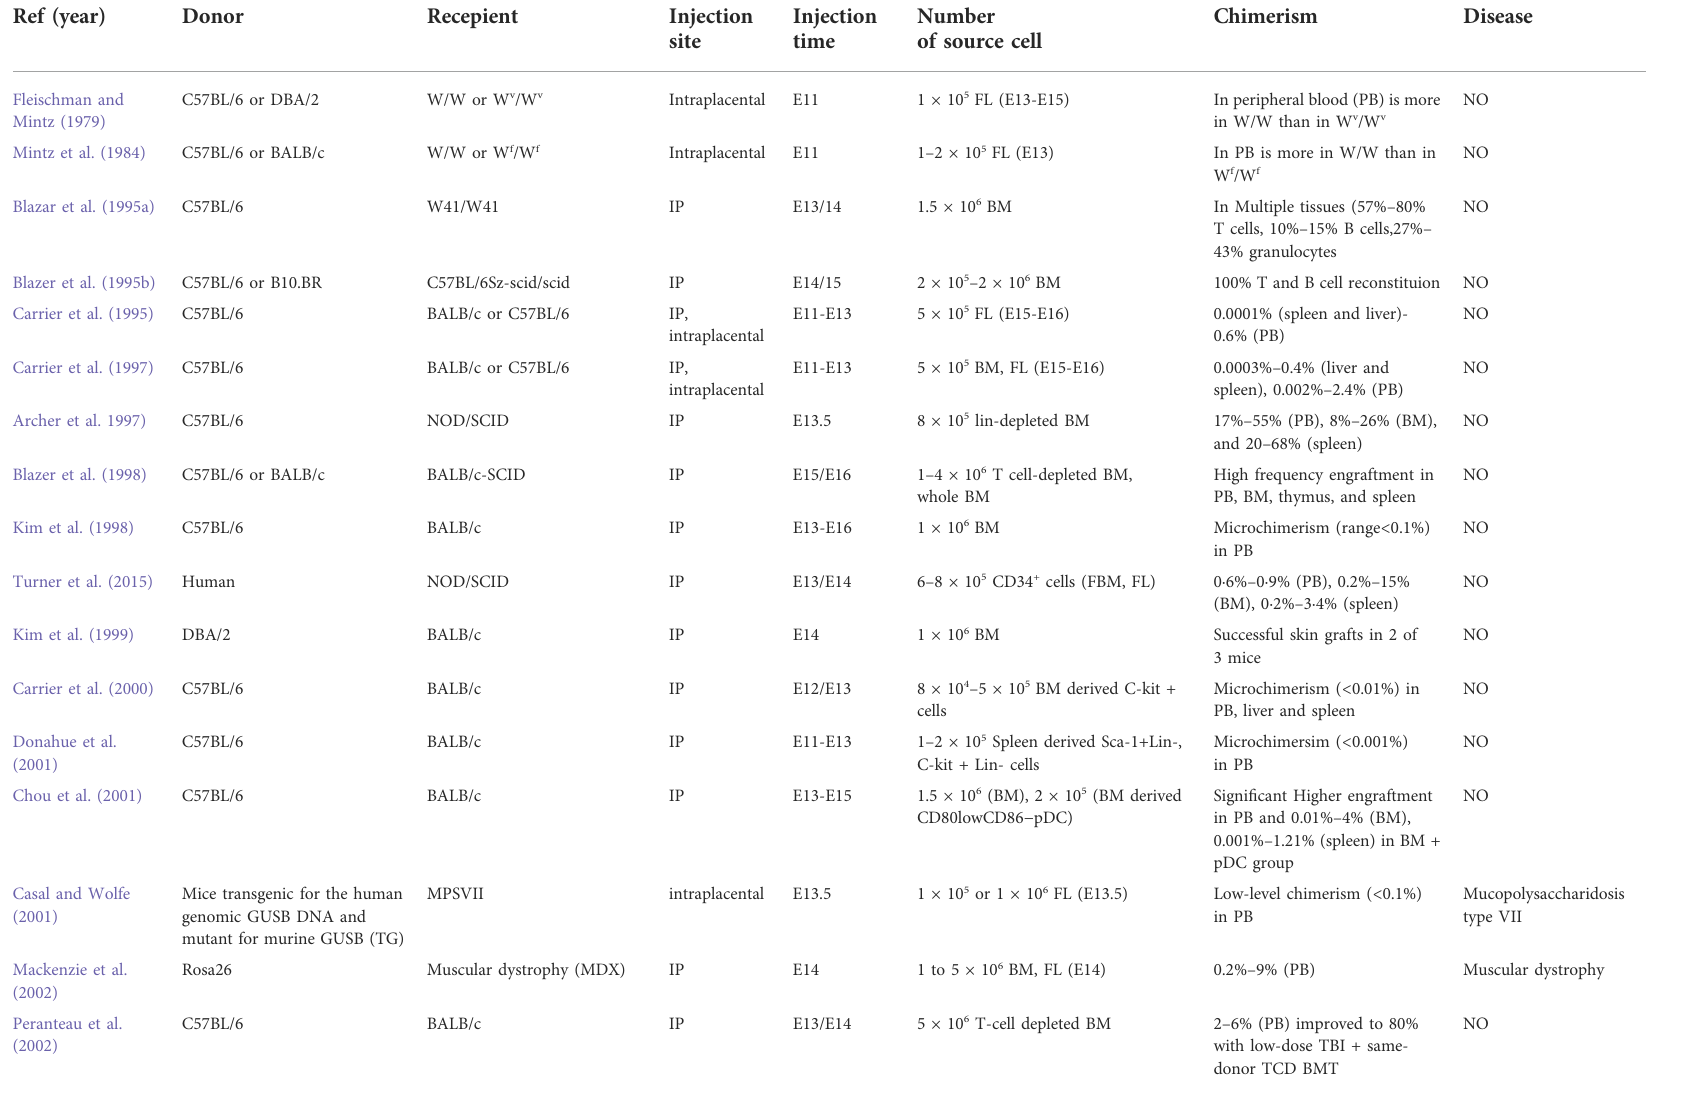
TABLE 1 IUT in murine